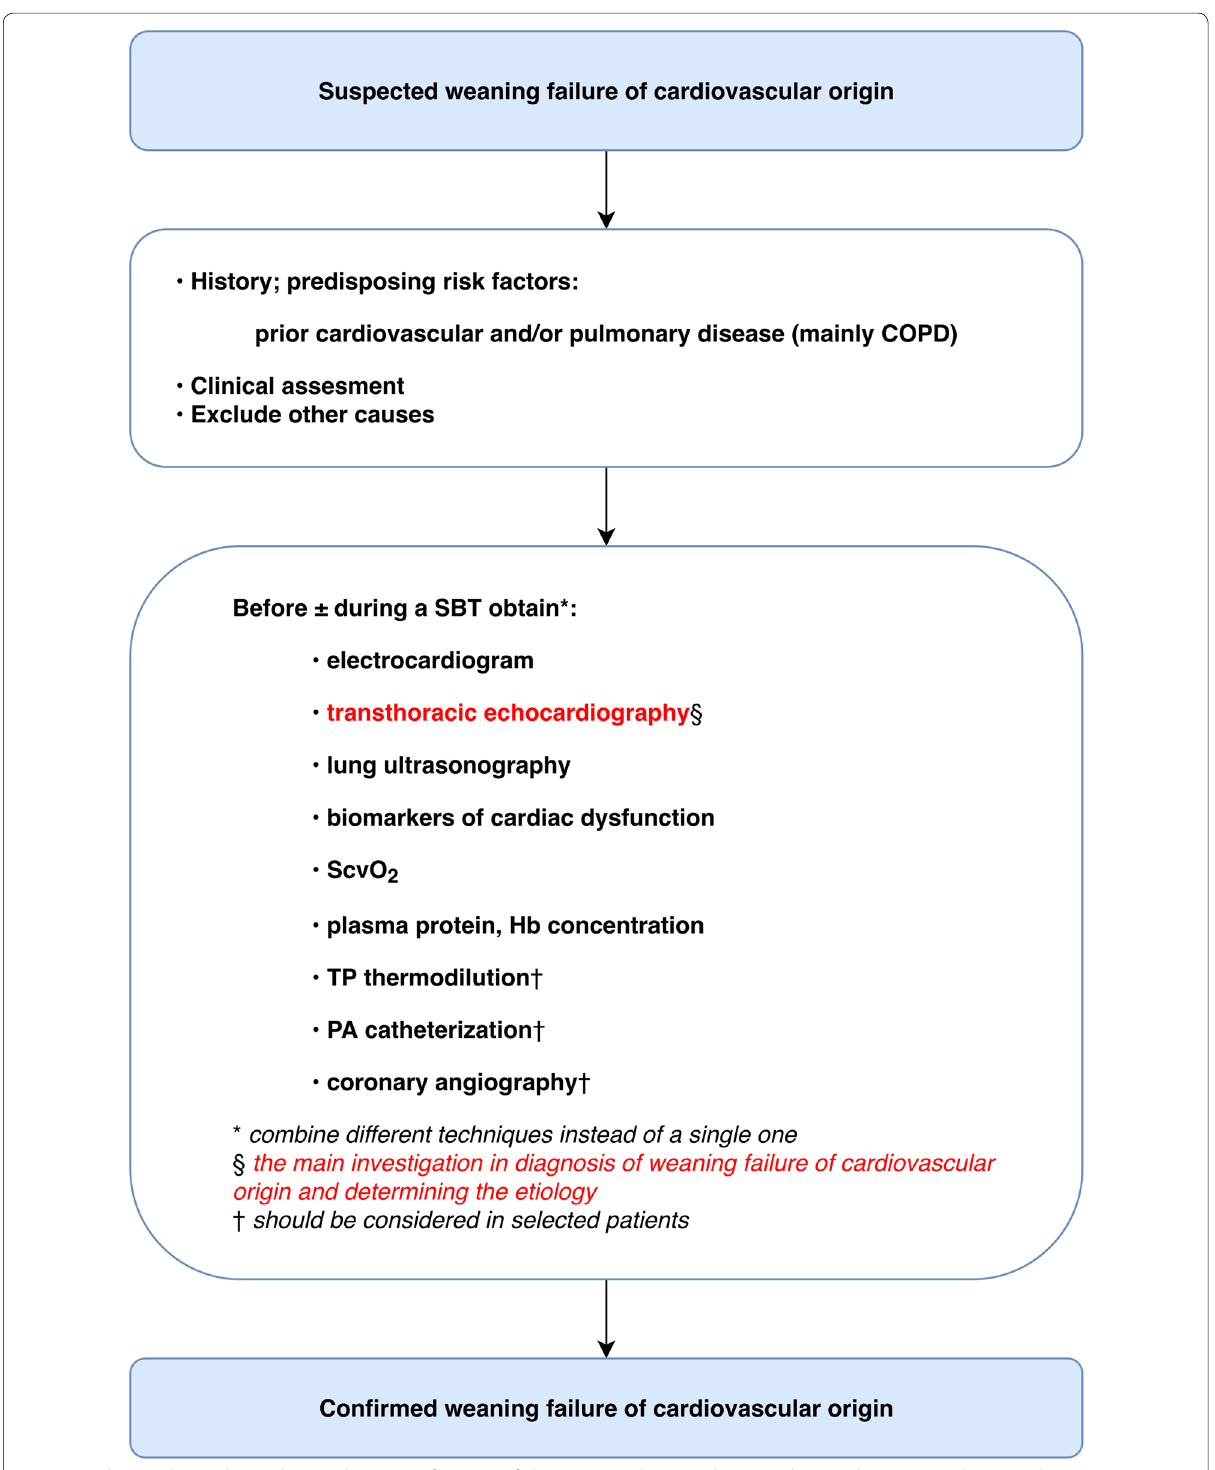
Fig. 2 Workup to detect the cardiovascular origin of weaning failure: a general approach. COPD chronic obstructive pulmonary disease, SBT spontaneous breathing trial, ScvO 2 central venous oxygen saturation, TP transpulmonary, PA pulmonary artery, Hb